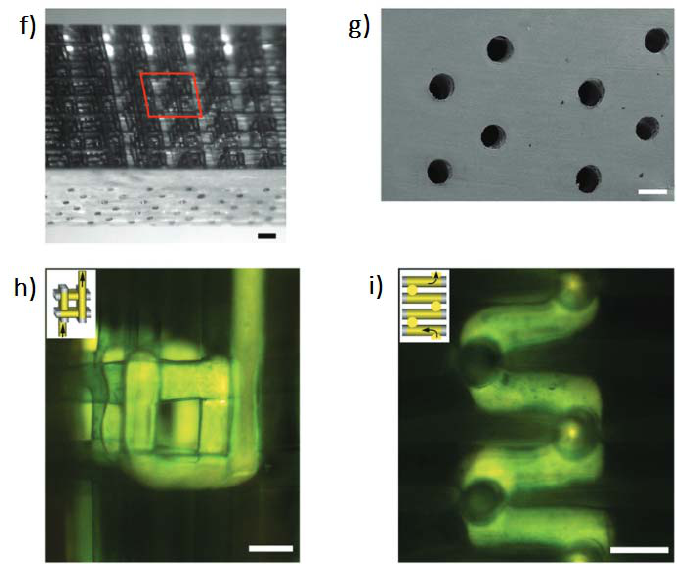
Figure 15. Microvascular scaffold fabrication. ( a ) Square ‐ spiral tower structure (yellow) embedded within the 3D microvascular network (blue); ( b ) Robotic deposition of the fugitive organic ink (blue) through a cylindrical nozzle onto a moving x–y stage; ( c ) Optical image (top view) of a 2D patterned feature within the microvascular scaffold; ( d ) Ink filaments produced from different nozzle diameters; ( e ) Optical image (top view) of microvascular scaffold; ( f ) 3D microvascular network embedded in clear epoxy matrix. Scale bar = 0.50 mm; ( g ) Scanning electron microscope image of the cross ‐ section of this network. Scale bar = 250 μ m; ( h – i ) Fluorescent microscope images (top view and side view respectively) of green fluid flowing inside a single tower structure showing its isolated nature. Scale bars = 250 μ m. (Reproduced with permission from [43]).